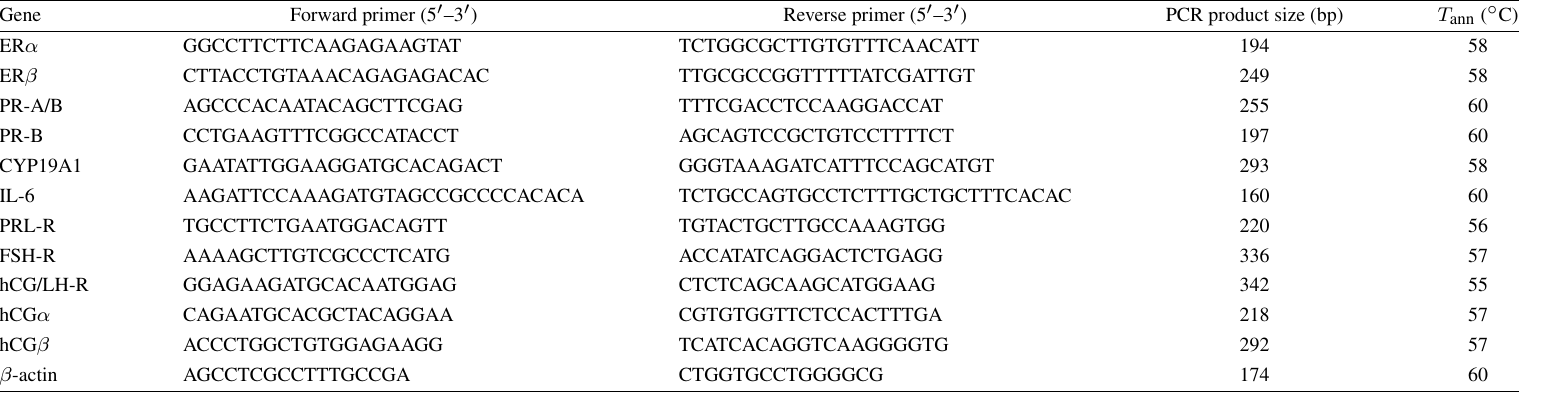
Sequences and annealing temperatures of primers used for qualitative analysis of gene expression